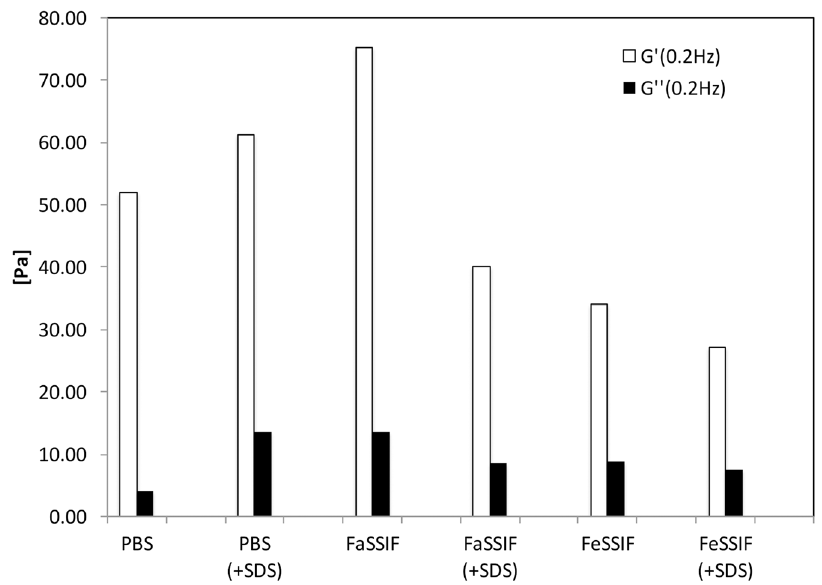
Fig 5. The elastic (G ’ , black bars) and viscous (G ” , hatched bars) moduli at 0.2 Hz shown for 1 wt% model gels in dissolution media with (+SDS) and without SDS in the gels. The SDS concentration was ca. 8 mM. The data points represent the mean values of two measurements and error bars show the standard deviation (n = 2).